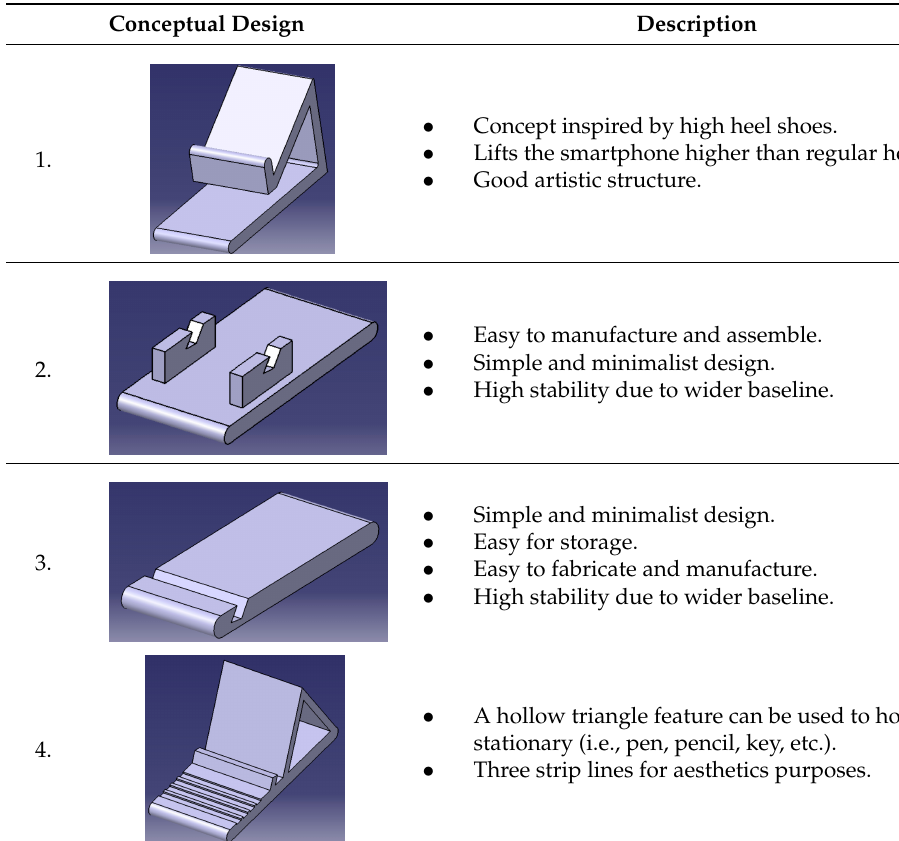
Table 5. New conceptual designs of a roselle fiber-reinforced polymer composite smartphone holder and their descriptions [108].